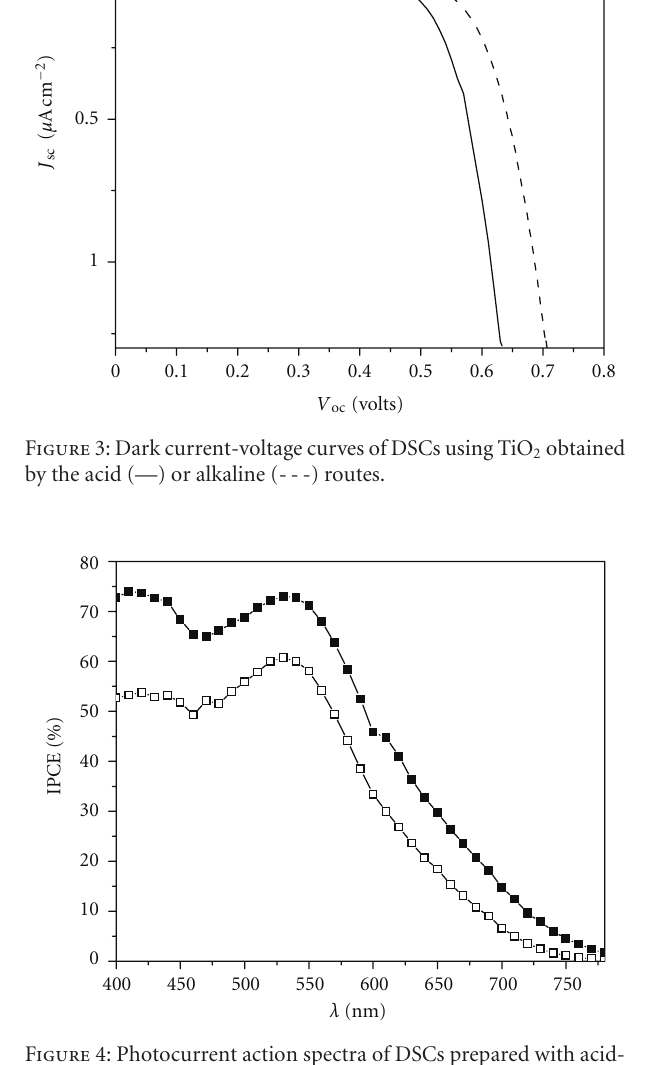
Figure 4: Photocurrent action spectra of DSCs prepared with acid- route TiO 2 films treated (-- (cid:3) --) and nontreated (-- (cid:4) --) by TiCl 4 solutions.